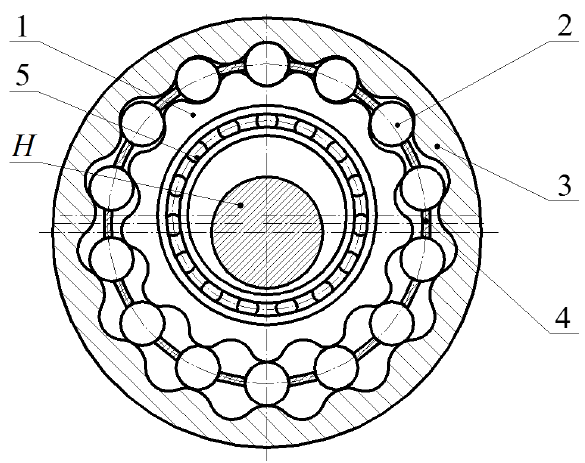
Figure 1. Cross-section of a transmission with intermediate rolling elements and a free cage: H— generator; 1—cam; 2—intermediate rolling elements; 3—ring; 4—cage; 5—bearing.